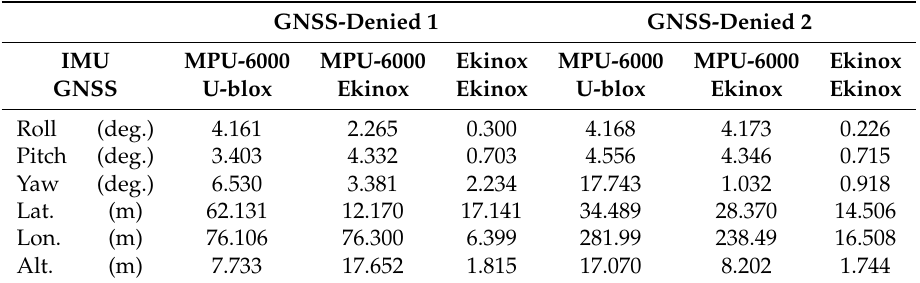
Table 6. RMSE from the three proposed navigation systems for the two GNSS-denied stretches.